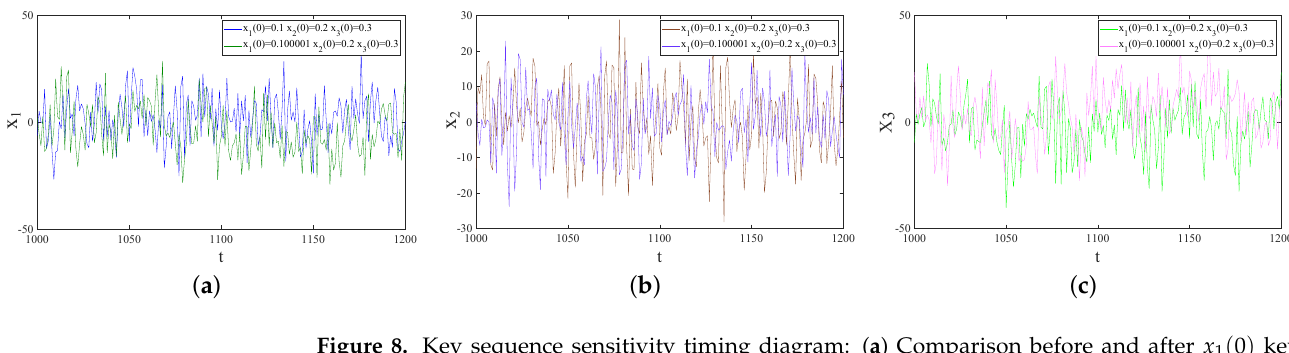
Figure 8. Key sequence sensitivity timing diagram: ( a ) Comparison before and after x 1 ( 0 ) key perturbation; ( b ) Comparison x 2 before and after x 1 ( 0 ) key perturbation; ( c ) Comparison x 3 before and after x 1 ( 0 ) key perturbation.